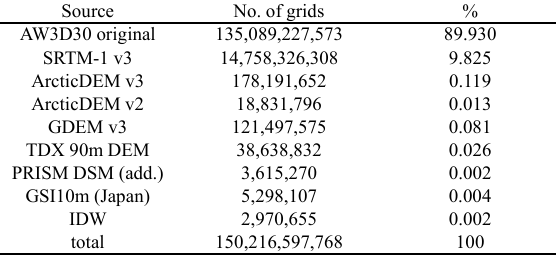
Table 3. Proportion of source data in the AW3D30